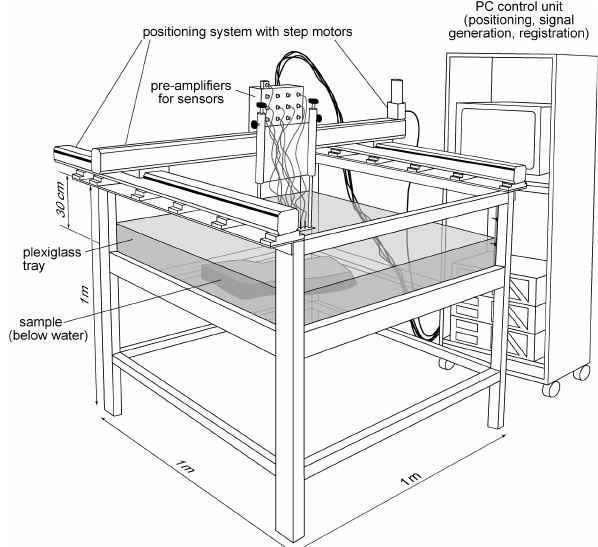
Fig. 1. Experimental device and setup of the mini-seismic system in the laboratory. The system consists of a seismic tank, a PC-driven control unit, a positioning system, and piezoelectric transducers (for technical details see also Table 1 and Figs. 2 and